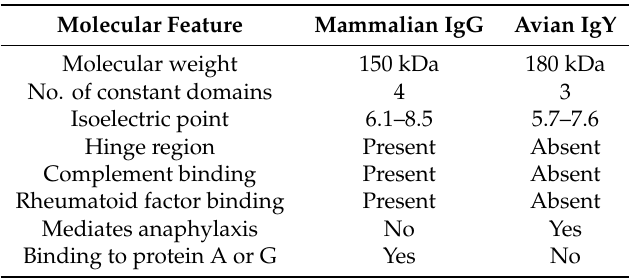
Table 1. Molecular features of mammalian and avian